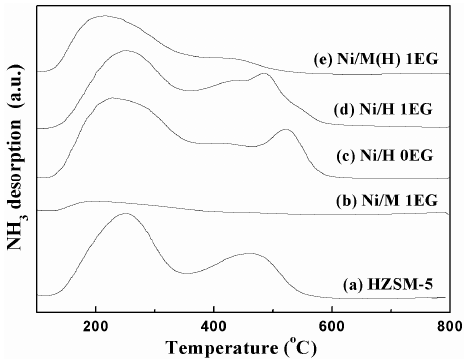
Figure 5. Ammonia desorption profiles from various samples without reduction (20 wt % Ni loading). Table 2. NH 3 ‐ TPD results of various Ni catalysts with 20 wt % Ni loading.